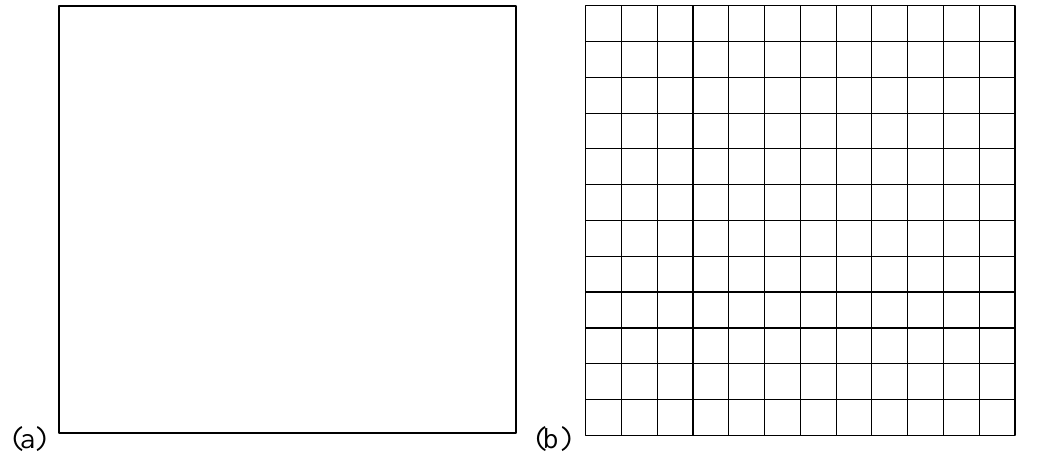
Figure 6. Schematic representation of a highly symmetric system of an ideal gas (dynamic symmetry, very homogenous and isotropic) (a) or a perfect crystal (static symmetry) (b) and the information loss. The highly symmetric paintings like (a) and (b) found in many famous modern art museums are the emperor's new clothes. These paintings are “reproduced” here without